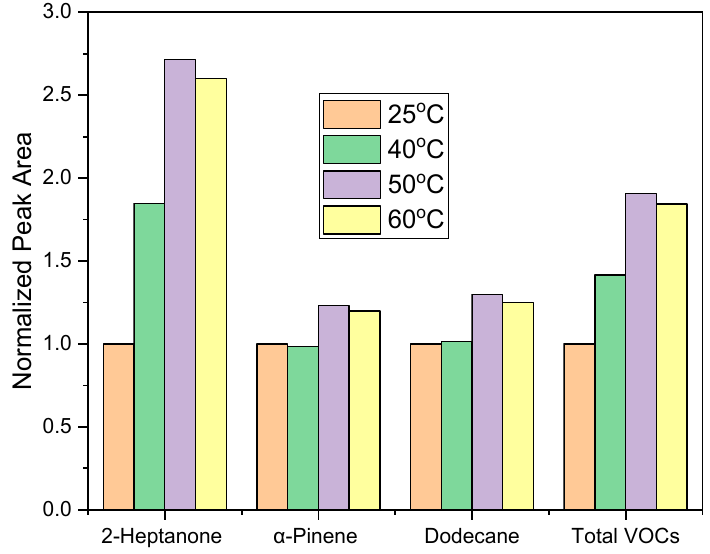
Figure 2. Evaluation of the extraction temperature for SPME